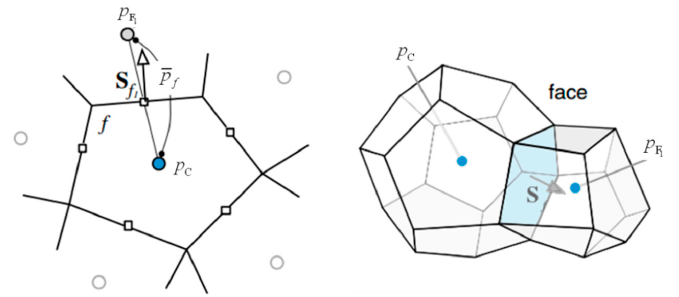
Figure 3. Gradient computation.